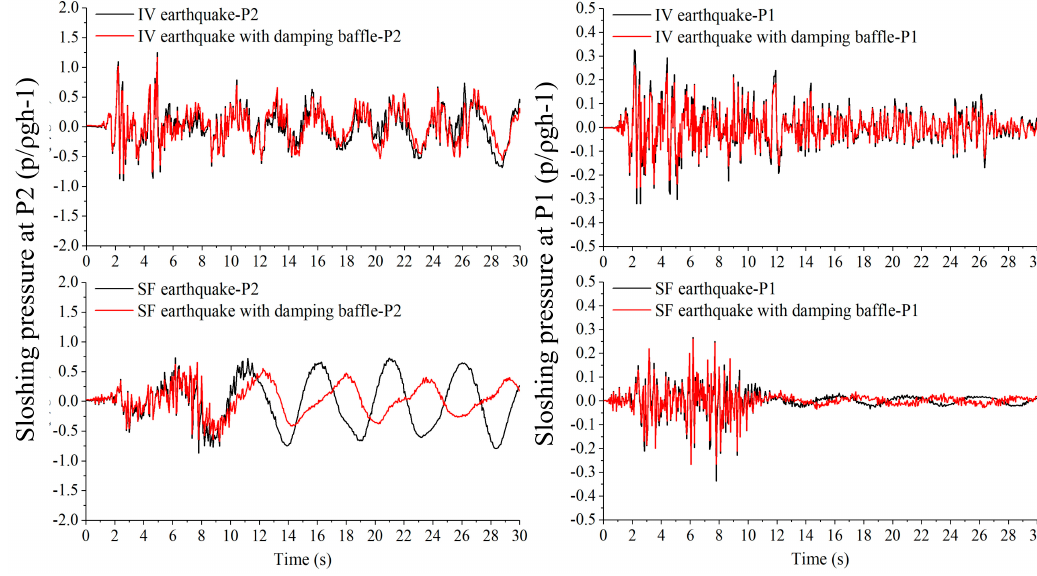
Figure 15. The fluctuation of sloshing pressure at selected points.